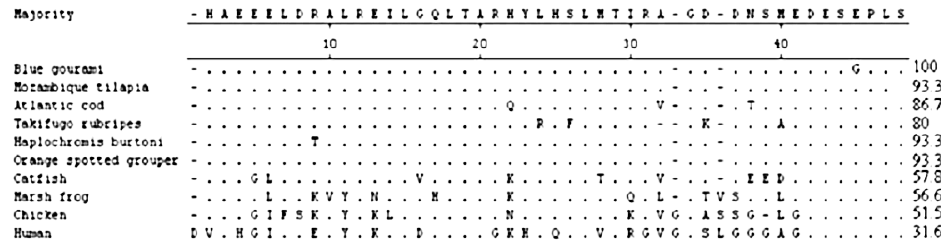
Figure 19. PRP ( A ) and PACAP ( B ) amino acid sequence comparison between blue gourami and other vertebrates. The sequence alignment was conducted using ClustalW and the MegAlign program (DNASTAR) on PRP and PACAP mature peptide sequences. Identical amino acids are represented by dots, and differing residues are shown in the single letter code for amino acids. In contrast to PRP, PACAP is highly conserved [36]. 6. GH and Prolactin (PRL) Family Hormones as Genetic Variation Markers for Blue Gourami and Other Anabantoid Fishes Growth hormone (GH) is a single-chain polypeptide. Together with prolactin, growth hormone and somatolactin, it forms a family of related polypeptide hormones whose sequences seem to have evolved from a common ancestor [31,33,36]. GH has been studied extensively, and cDNA sequences are available for blue gourami (Figure 20) and many other teleosts. The study of GH expression in relation to growth and the reproductive cycle could contribute to an understanding of the interactions between somatotropic and gonadotropic axes at the pituitary level in order to elucidate the ef- fects of GH on fish reproduction [31,33,36]. Other HPS axis genes that control growth and that are involved in cell division have been sequenced in blue gourami but less in other species of Anabantoid fishes [7,31,36,41,42].